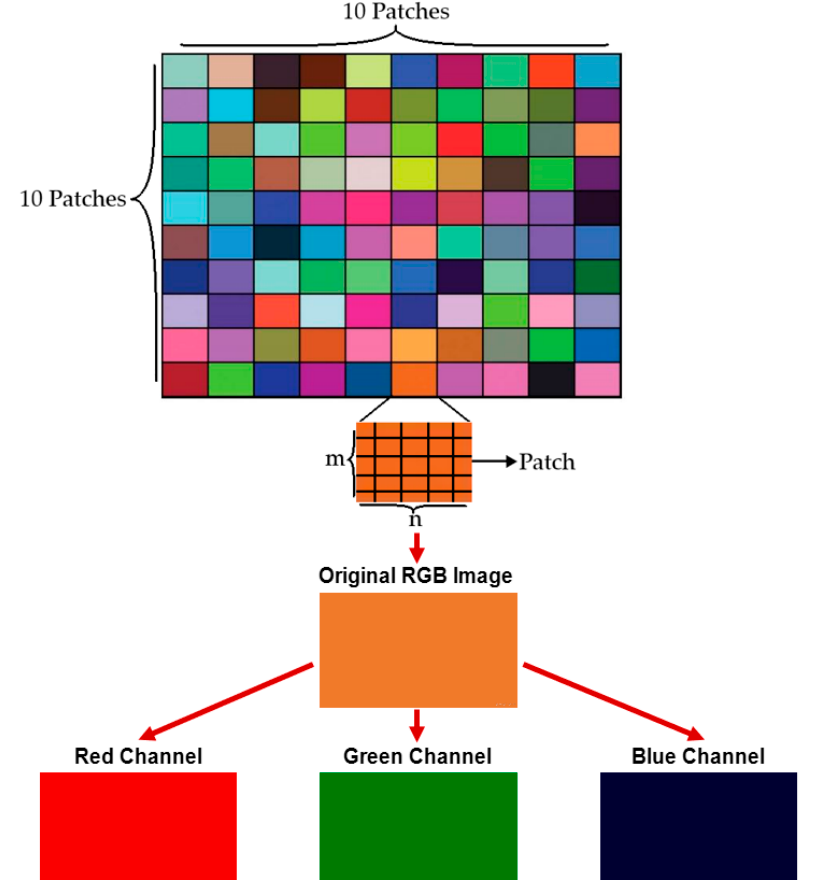
Figure 3. Color correction step. Color chart with 100 patches (10 × 10 patches) were generated. Each patch inside the color chart is an image with m × n pixels. Each patch is presented in its R, G, B color channel components.